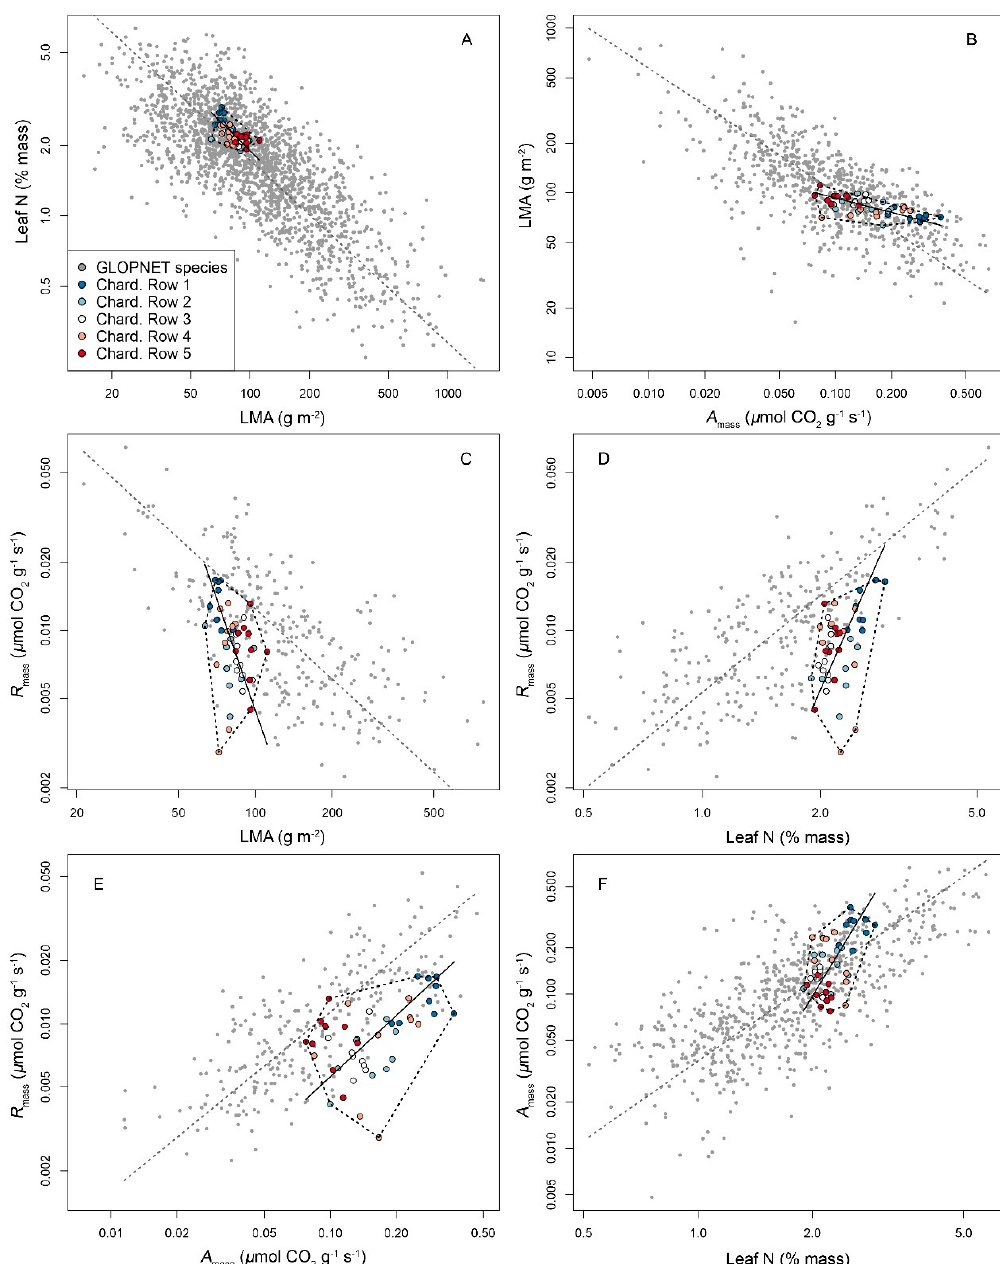
Figure 3. Relationships across four Leaf Economics Spectrum traits in ‘Chardonnay’ wine grapes. Trait acronyms are light-saturated maximum photosynthetic rate on a per leaf mass basis ( A mass ; Panels B , E , F ); leaf respiration rate on a per leaf mass basis ( R mass ; Panels C , D , E ); leaf mass per unit area (LMA; Panels A , B , C ); and leaf nitrogen (N) concentration (Panels A , D , F ). Colours correspond to sampling rows reflecting a soil compaction gradient: black solid trend lines correspond to the standardized major axis (SMA) regression model of a given bivariate trait relationship in ‘Chardonnay’, and dashed black trend lines represent convex hull models that encapsulate the two-dimensional trait space occupied by ‘Chardonnay’ leaves. Also shown are the data and SMA models for the same LES trait relationships observed among wild plants in the GLOPNET dataset (grey dashed trend lines and points). Details on all SMA models shown here are presented in full in Table 2.